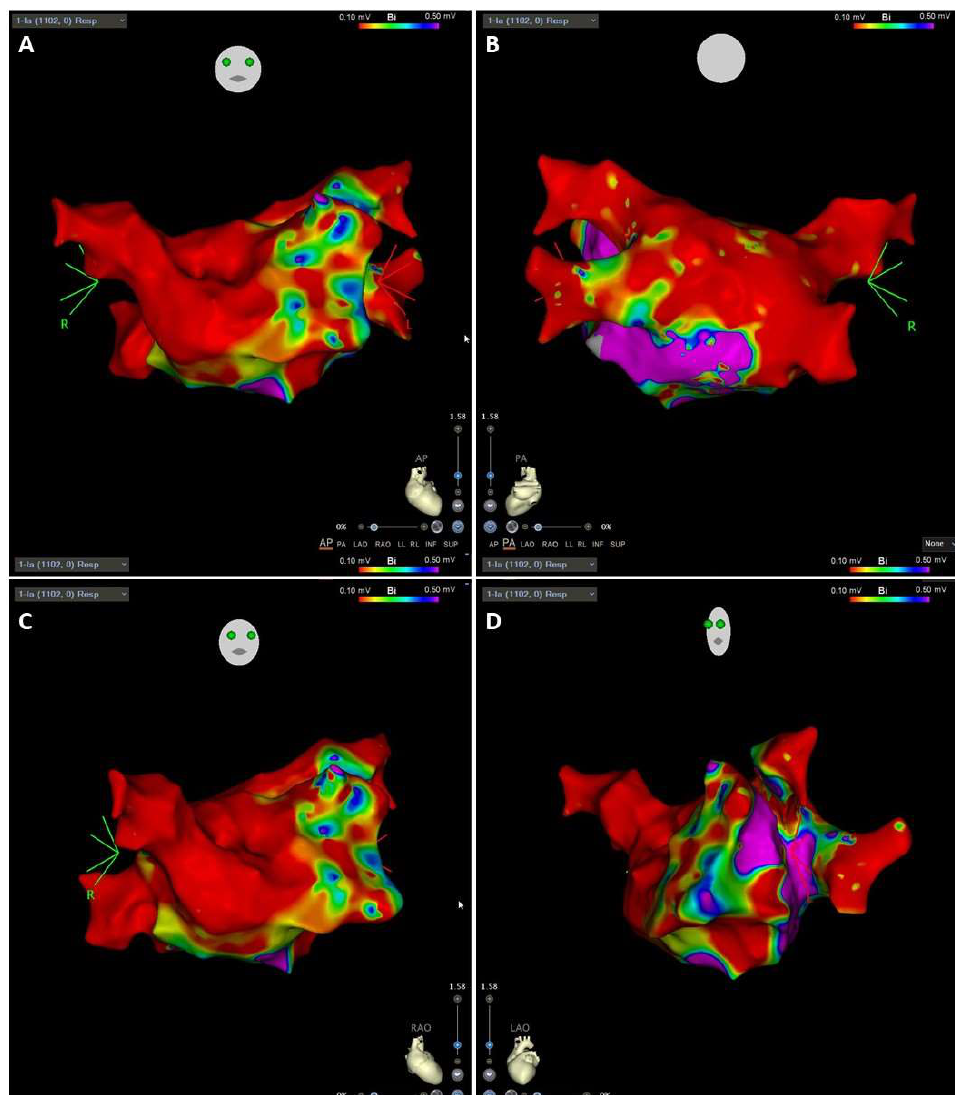
Figure 11. Substrate voltage map of LA in a patient with AF. Substrate voltage map of bipolar electrograms in the LA, performed in a patient with AF. The zones with voltage >0.5 mV identify normal tissue and are shown in purple and the red zone denotes voltage <0.1 mV and identify endocardial scar. Green, yellow, and blue represent intermediate voltages. Three-dimensional (3D) position coordinates were recorded with CARTO 3 (Biosense Webster, Diamond Bar, CA, USA) and a 20-pole circular mapping catheter. Peak-to-peak voltages were collected from the 10 dipoles and a high-density bipolar voltage map was created. Left atrial voltage and activation maps were constructed during SR before ablation. ( A , B ): 2 images of the same map are shown in anteroposterior (AP) posterior anterior (PA) projections, respectively. ( C , D ): 2 images of the same map are shown in right anterior oblique (RAO) and left anterior oblique (LAO) projections,